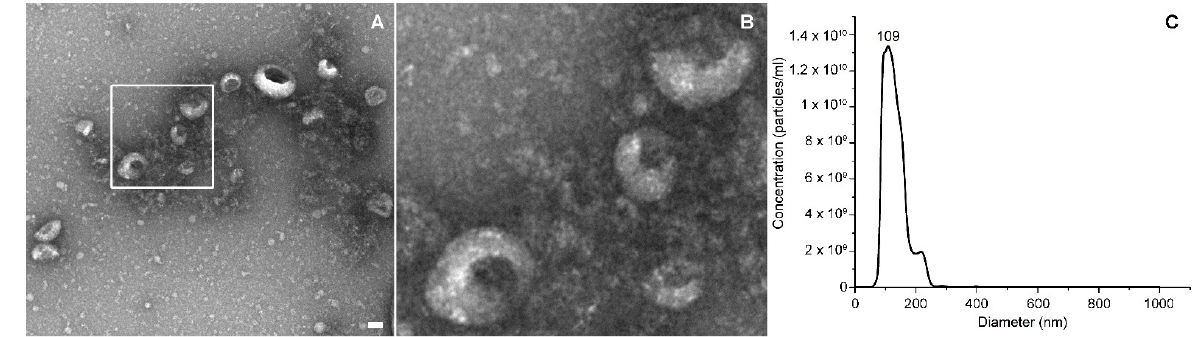
Figure 2. Panel ( A ) represents a TEM image of EVs and ( B ) a higher magnification of the vesicles in the white box. Scale bar: 50 nm. In panel ( C ), there is an NTA representative size distribution graph.